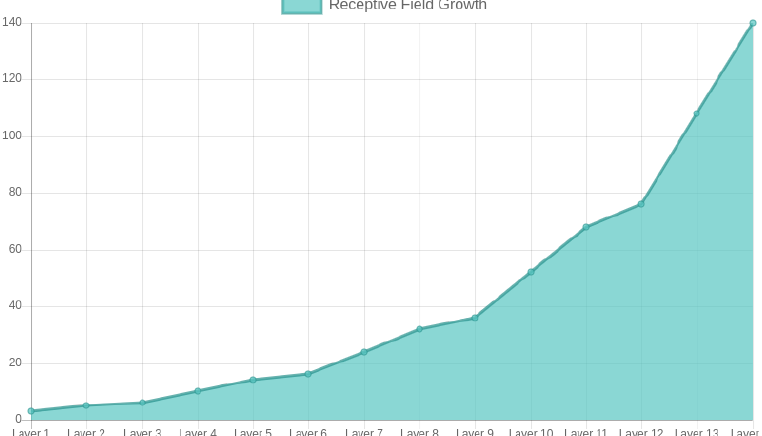
Figure A2. Growth of the receptive field in the layers of the